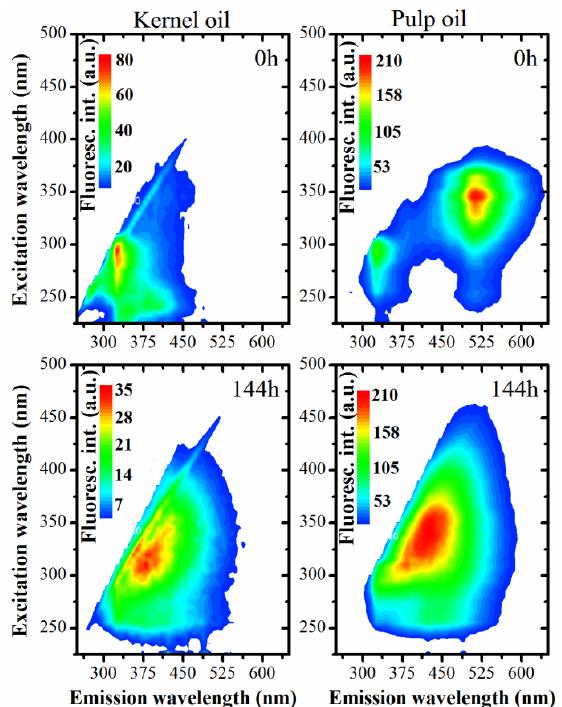
Figure 7. Excitation-emission contour maps of the kernel and pulp oil for heating times of 0 and 144 h. Oils were diluted in hexane 1.5 w / v .